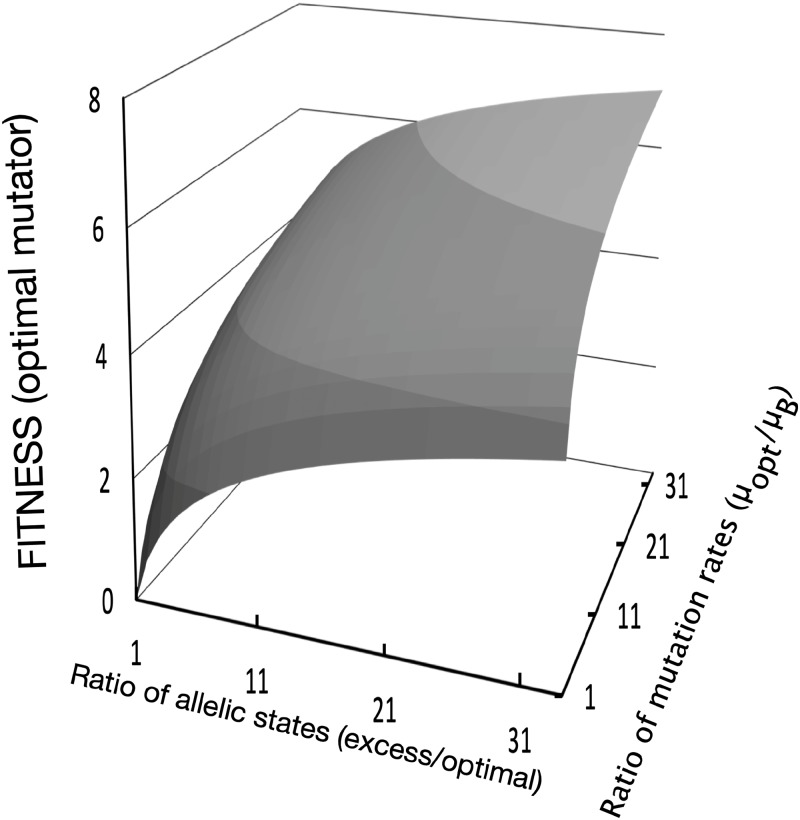
The fitness of localized mutators is strongly affected by the number of allelic states and the rate of mutagenesis to alleles.The model predicts that optimal mutators have the minimum number of necessary allelic states and high rates of localized mutagenesis, as is seen in natural systems. Fitness is determined by the difference in malthusian parameters [31, 32].